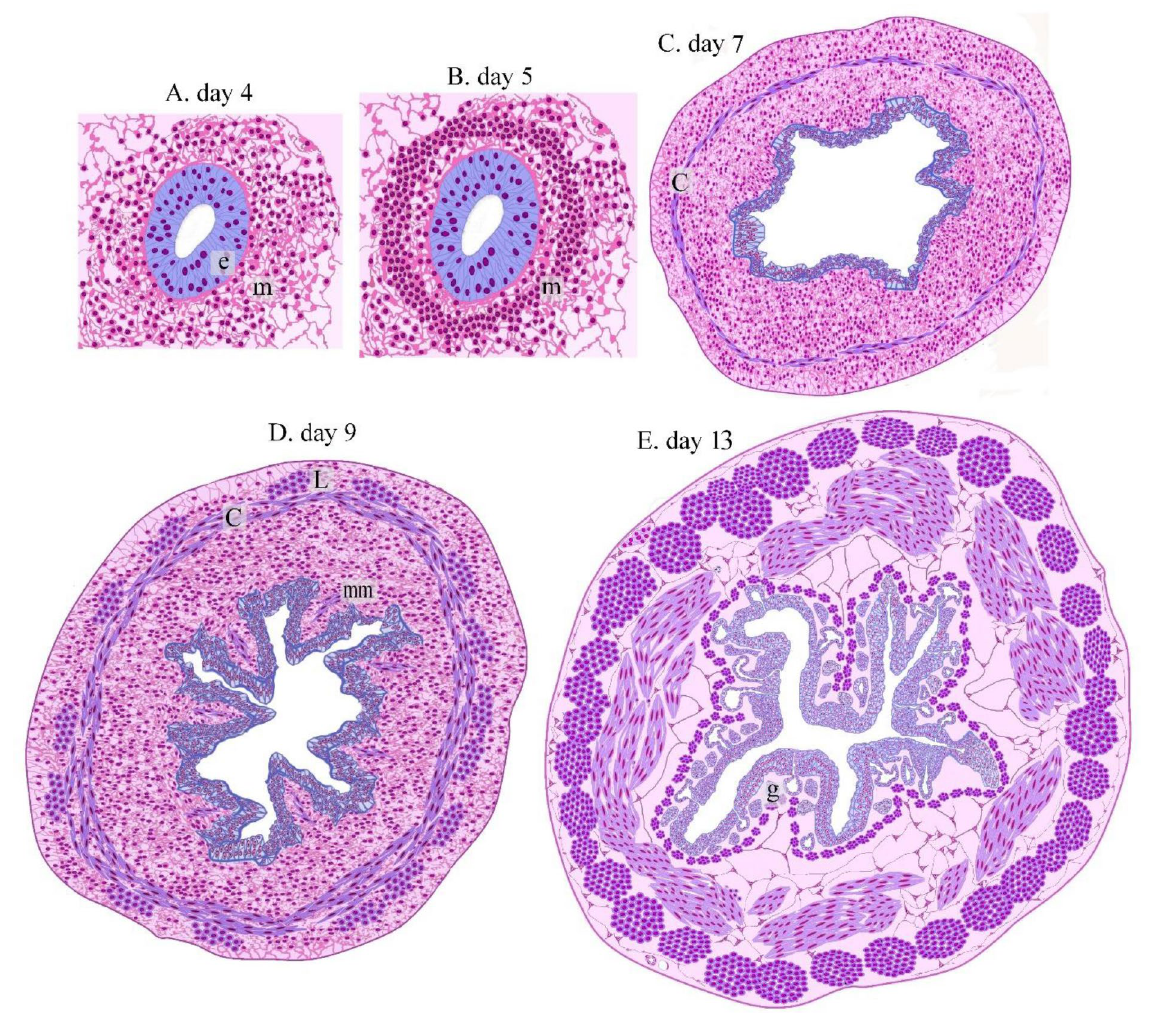
Figure 15. Illustration of sequences of histological events occurring during esophageal development. ( A ) Day 4. The gut tube was formed, consisting of endoderm (e) and mesoderm (m). ( B ) Day 5. mesenchymal cell condensation (m) occurred as a sign for development of the muscular layer. ( C ) Day 7. Development of the inner circular SMC (c). ( D ) Day 9. development of the inner circular SMC (c). outer longitudinal (L) and muscularis mucosae (mm). ( E ) Day 13. Development of the gland